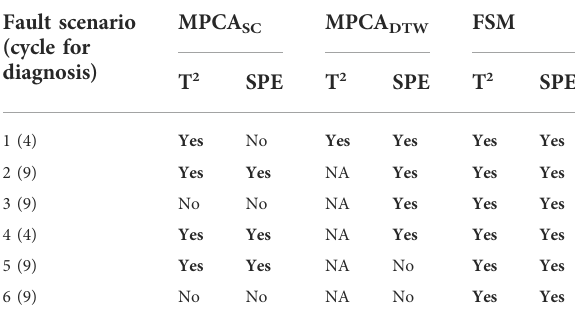
TABLE 5Detailsof the fault diagnosis results by T 2 and SPE. Onefaulty cycledetectedbyallmethodsisselectedforeachfaultscenario.If the faulty step is correctly identi fi ed, it is marked as “ Yes ” , otherwise marked as “ No ” . If the faulty cycle is not detected as a fault, its diagnosis is marked as “